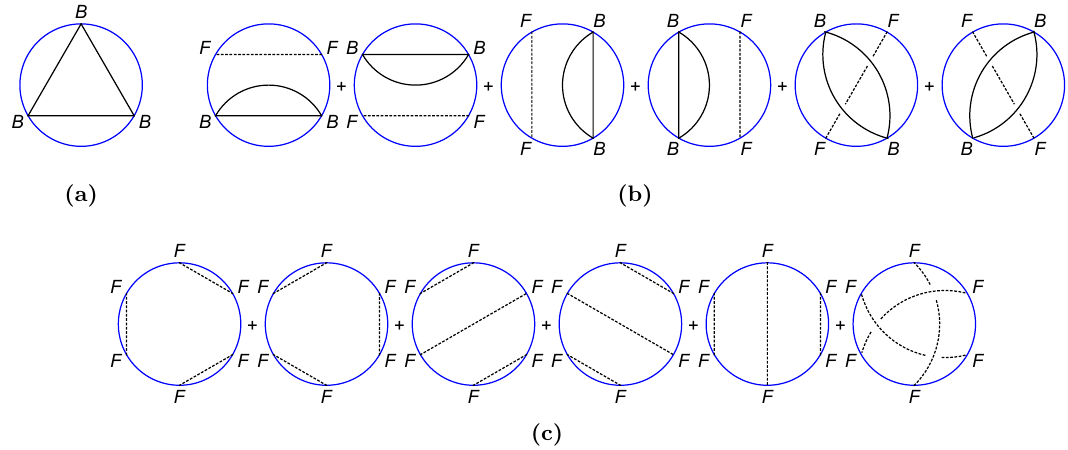
Figure 8. Three-loop Feynman diagrams for h Tr P (e (cid:0) i H d(cid:28)L bos ( (cid:28) ) W 6 ) i f